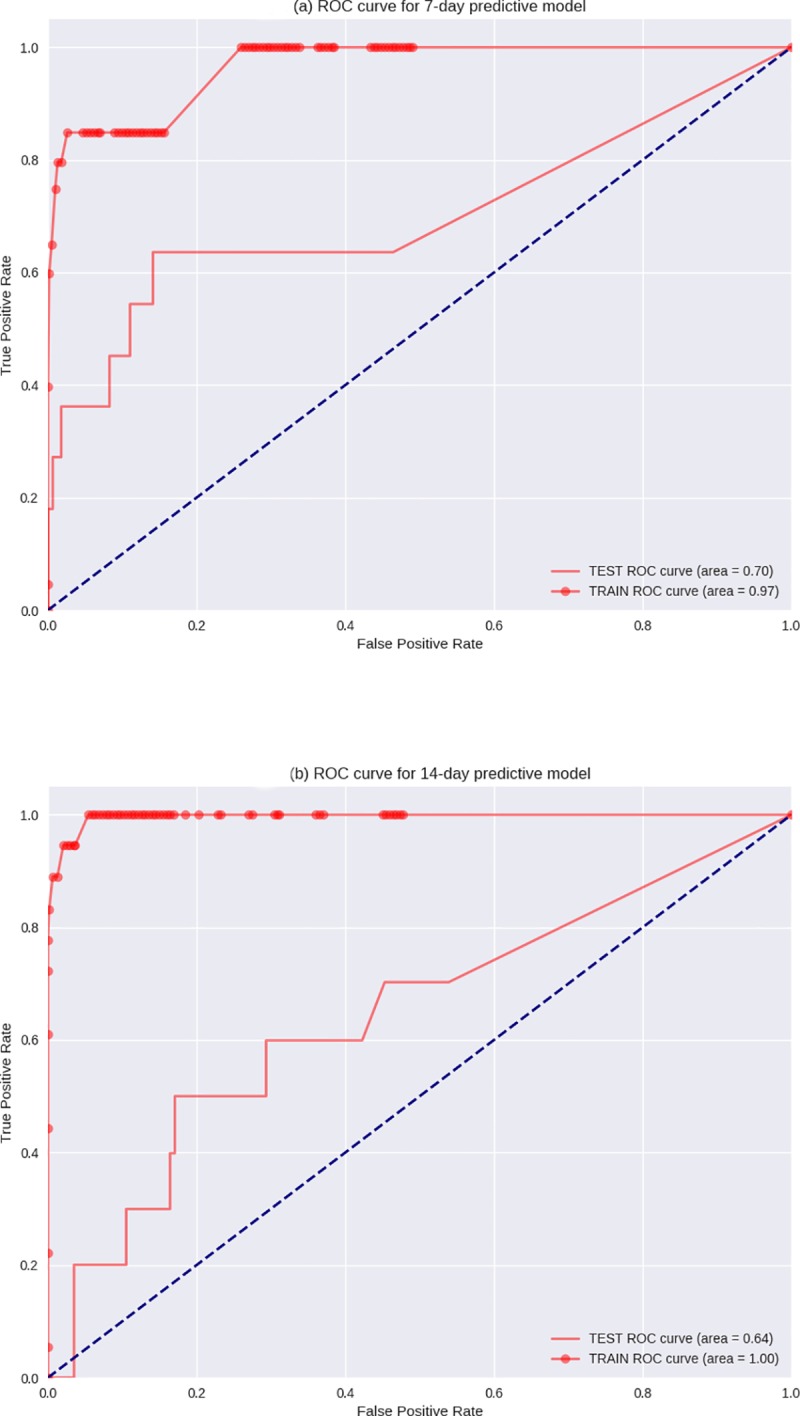
(a) ROC curve for 7-day predictive model and (b) ROC curve for 14-day predictive model.